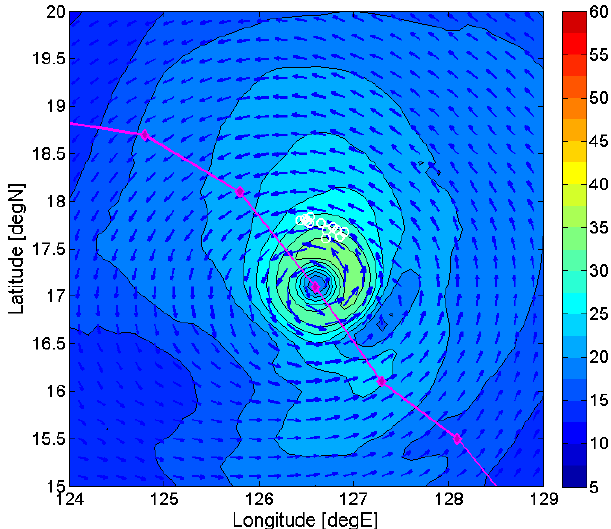
Figure 3. The wind speed [ms − 1 ] and wind direction (blue arrows) at 06Z on 21 September 2008. The best track of typhoon Hagupit is plotted as the magenta line with the diamonds denoting the 12h storm position. The white circles indicate the daily Argo float locations between 18 September and 29 September 2008.